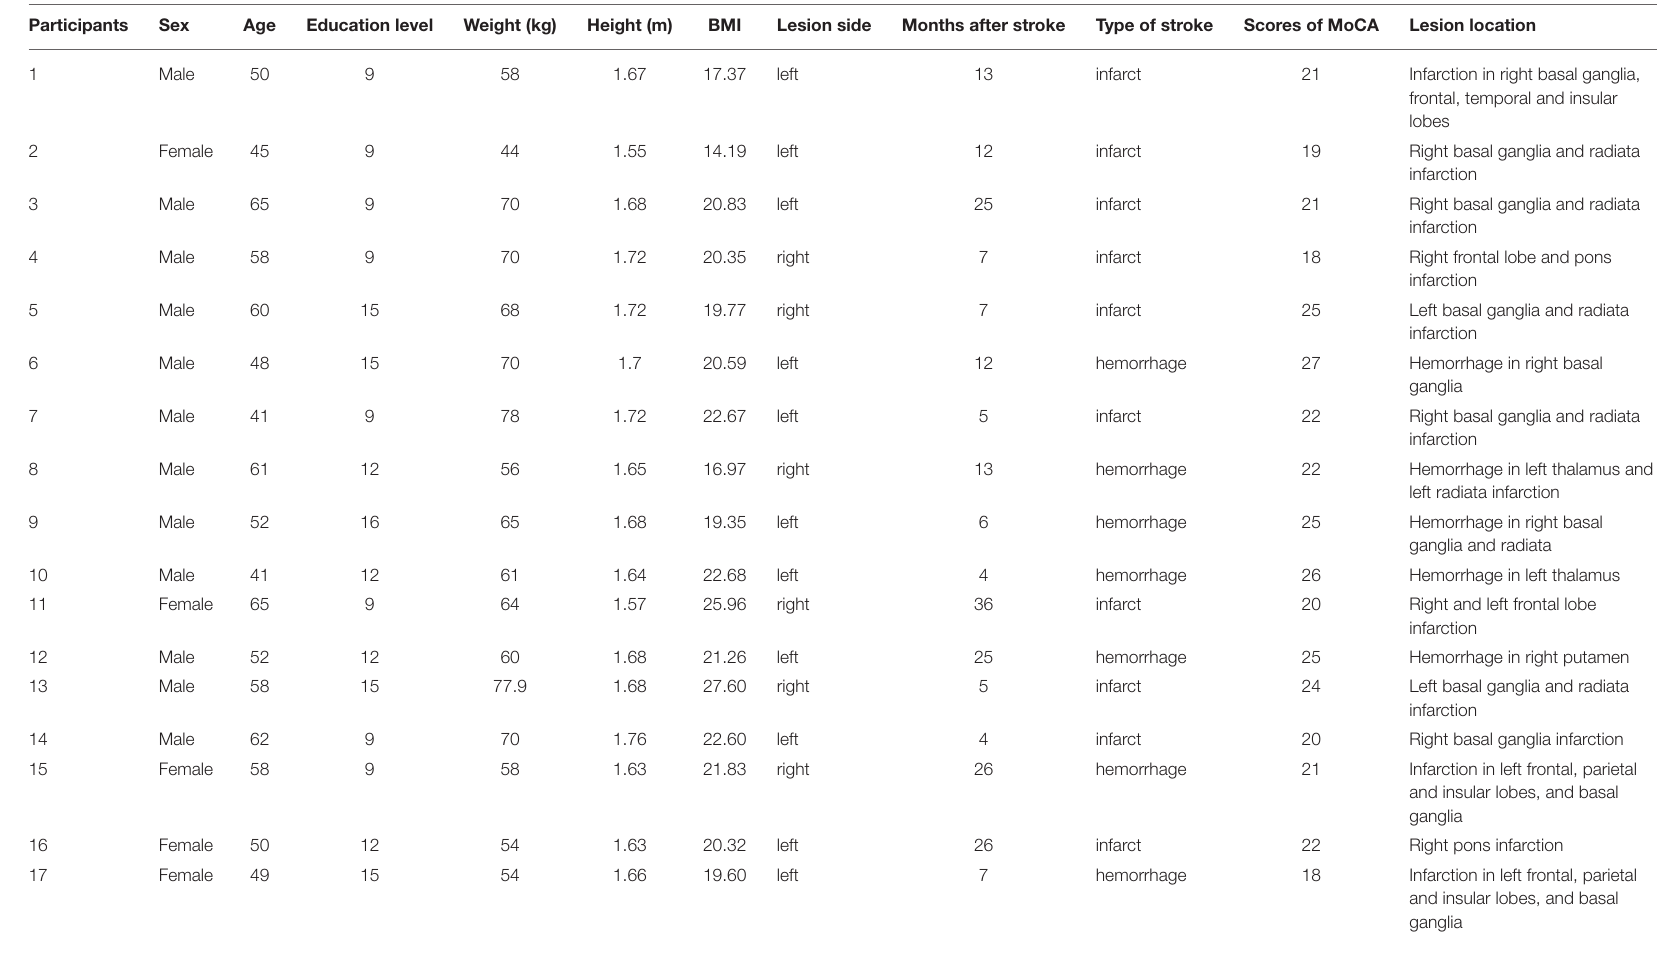
TABLE 2 | The clinical characteristics of the 17 chronic post-stroke